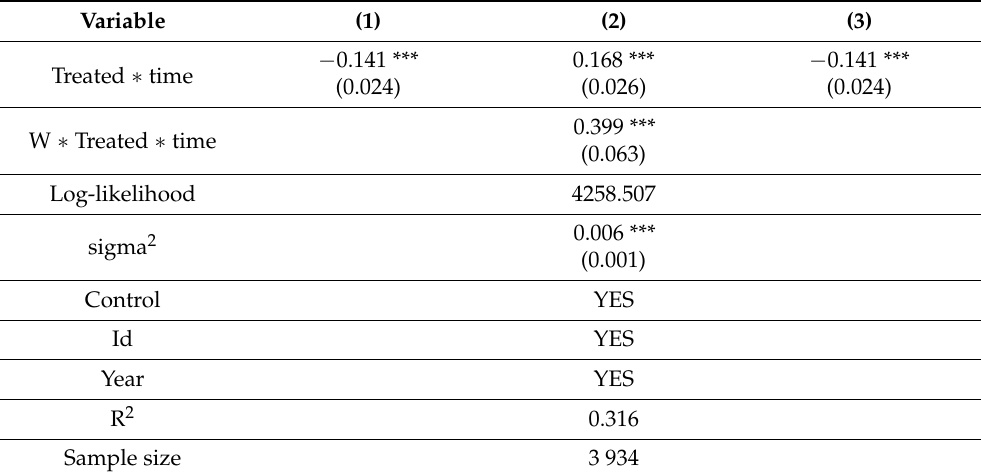
Table 10. Regression results of spatial Durbin